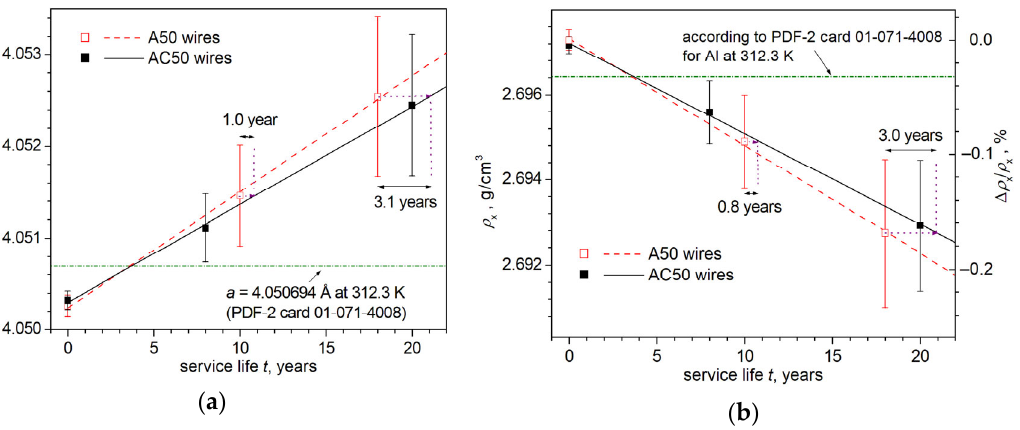
Figure 13. The dependences of ( a ) the Al cubic crystal unit cell parameter a and ( b ) density ρ x calculated from the XRD data on the service life t of the Al wires of overhead power transmission lines. At the right axis of ( b ), the scale of the corresponding density defect (reduction of density) Δ ρ x / ρ x (where Δ ρ x = ρ x − ρ x 0 years, ρ x 0 years is the mean density of the A50 wire N5 ‐ 2 (service life of 0 years)) of the Al wires is shown. The horizontal line in ( a ) indicates the tabulated value of the Al cubic unit cell parameter a according to the PDF ‐ 2 card 01 ‐ 071 ‐ 4008 [50] and that in ( b ) exhibits the corresponding calculated ρ x value. The lines running through the experimental points are guides to the eye only. In the graphs ( a , b ), the duration of the delay of changes of the a and ρ x parameter values for A50 and AC50 wires are shown for two service life points.